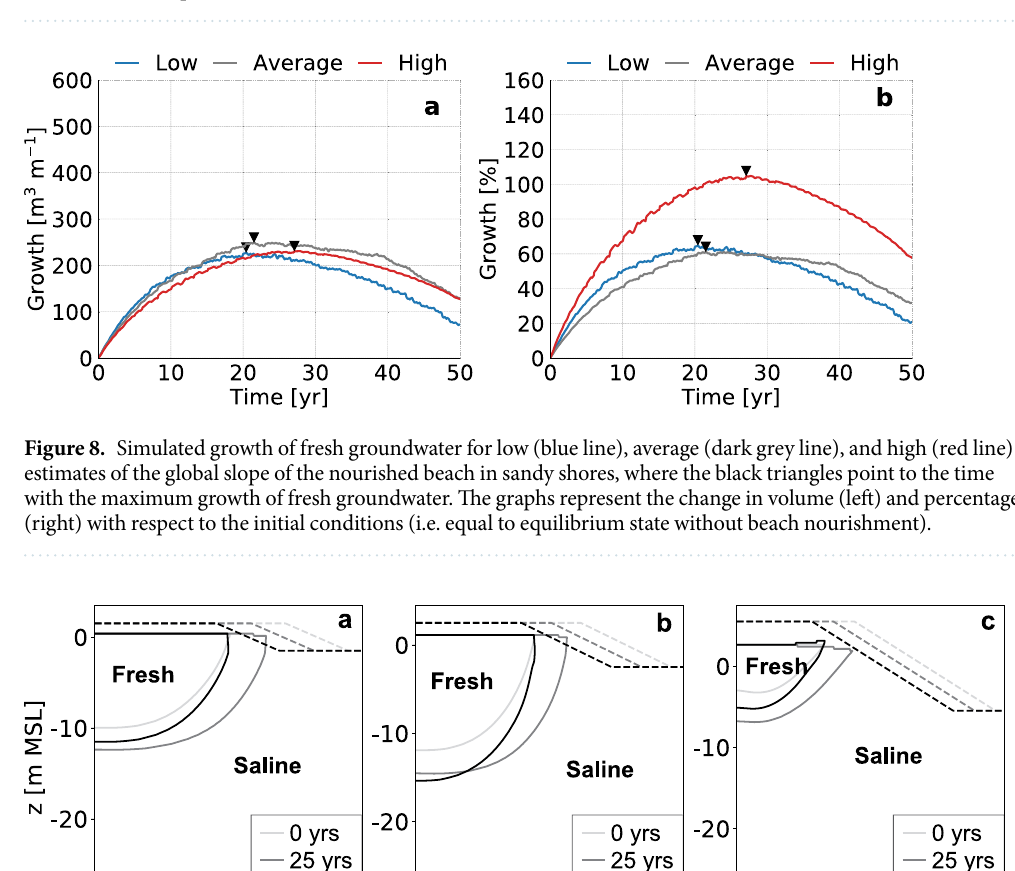
and near the intertidal zone. The optimum with respect to fresh groundwater resources, occurs therefore in inter- mediate tidal ranges.